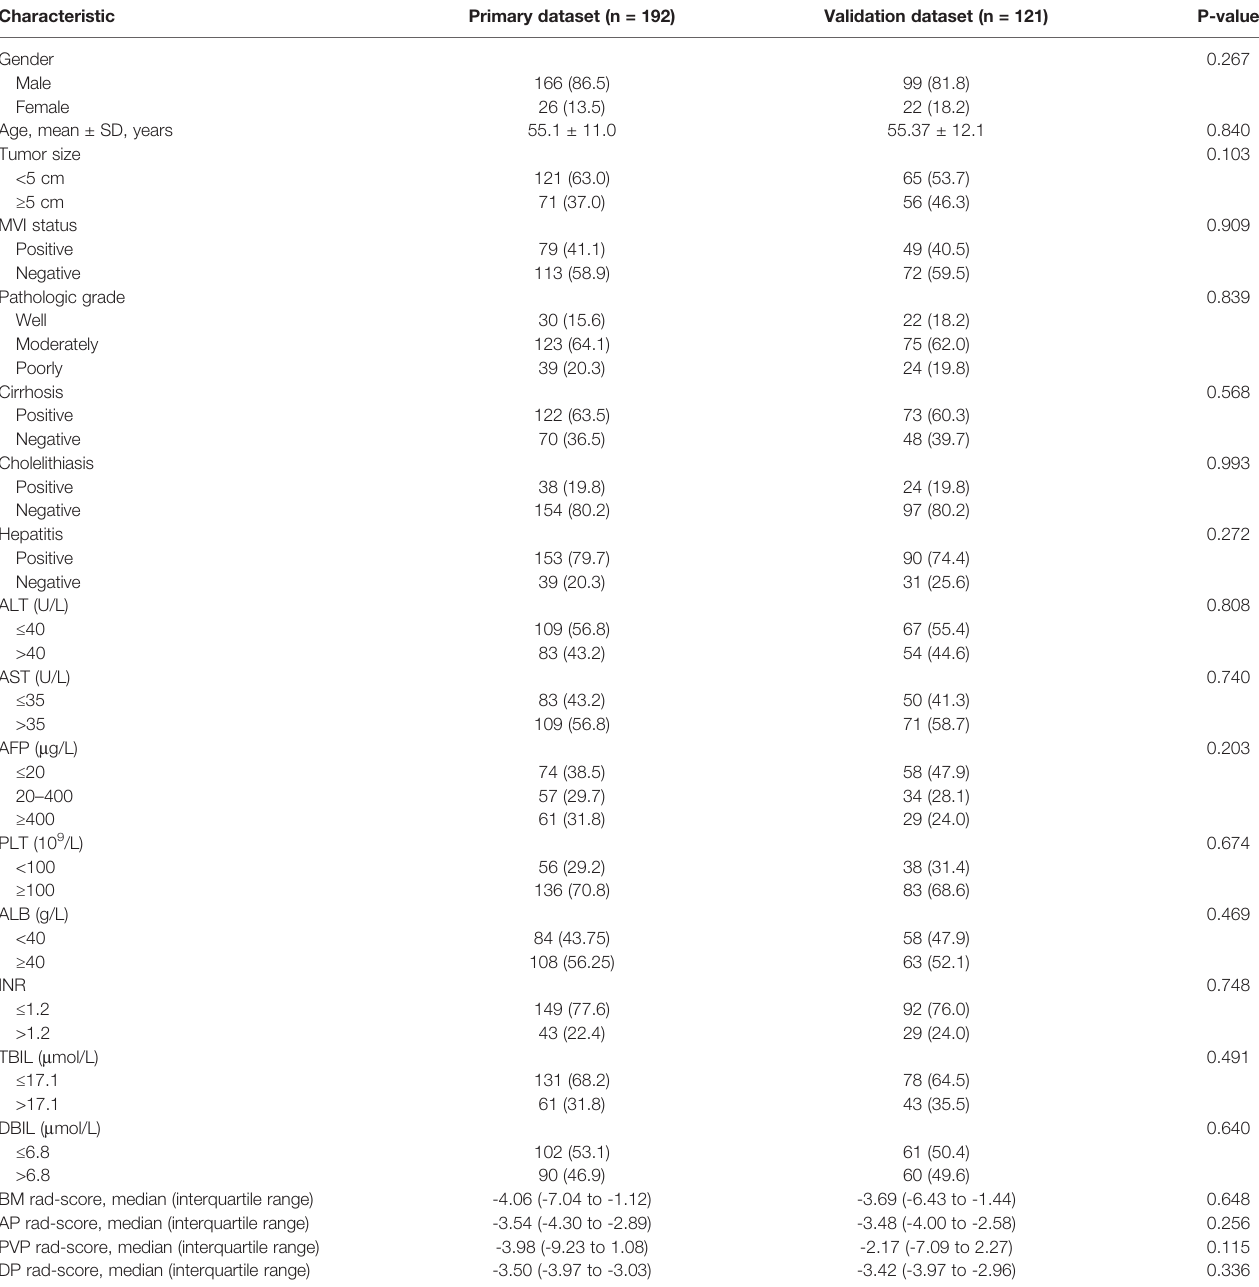
TABLE 1 | Clinicopathological characteristics in the primary and the validation datasets.